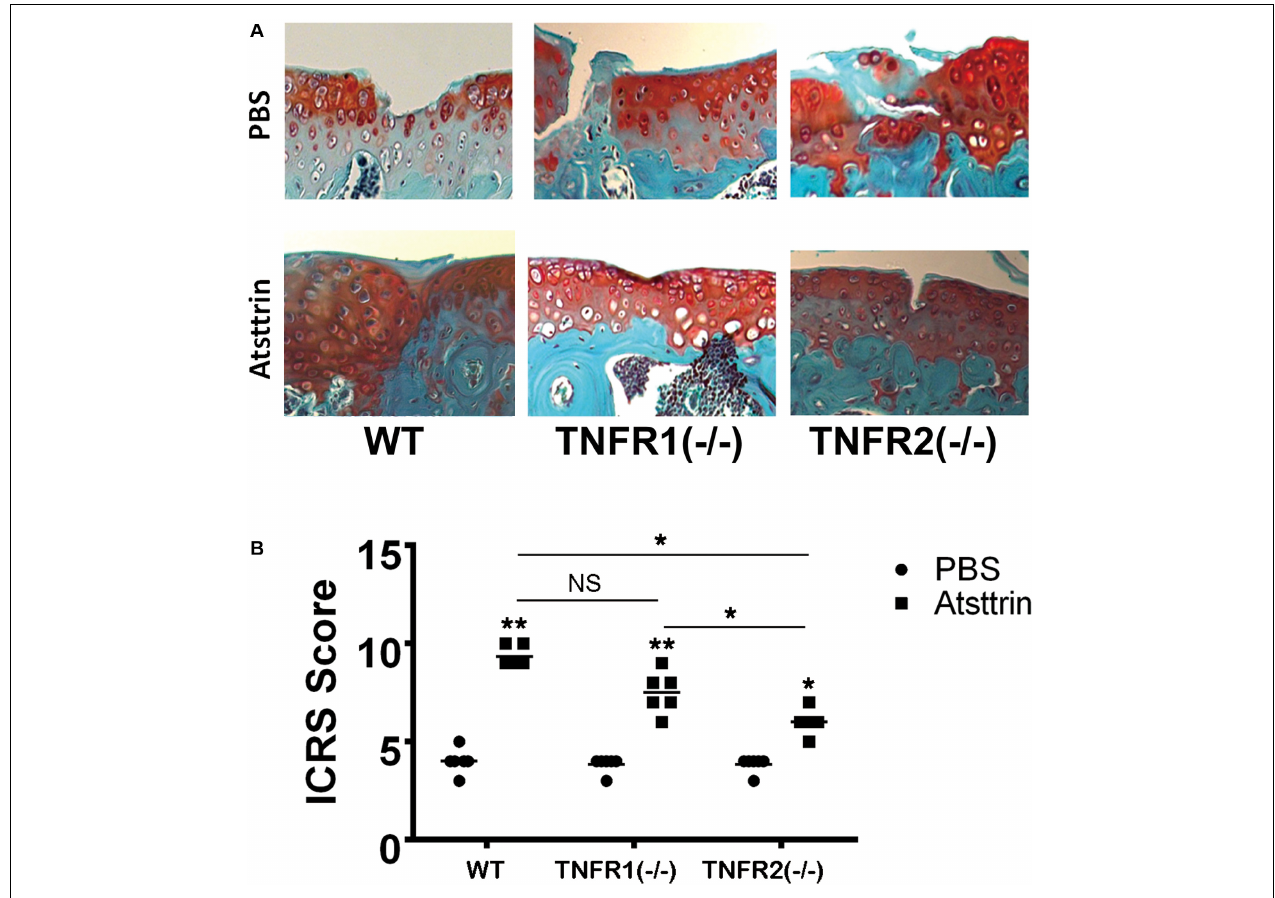
FIGURE 3 | Atsttrin accelerated cartilage repair through TNFRs. (A) Atsttrin promoted cartilage regeneration following surgically induced cartilage defect model relative to PBS ( n = 6 per group), assayed using safranin O staining. (B) International Cartilage Repair Score (ICRS) based on the result of safranin O